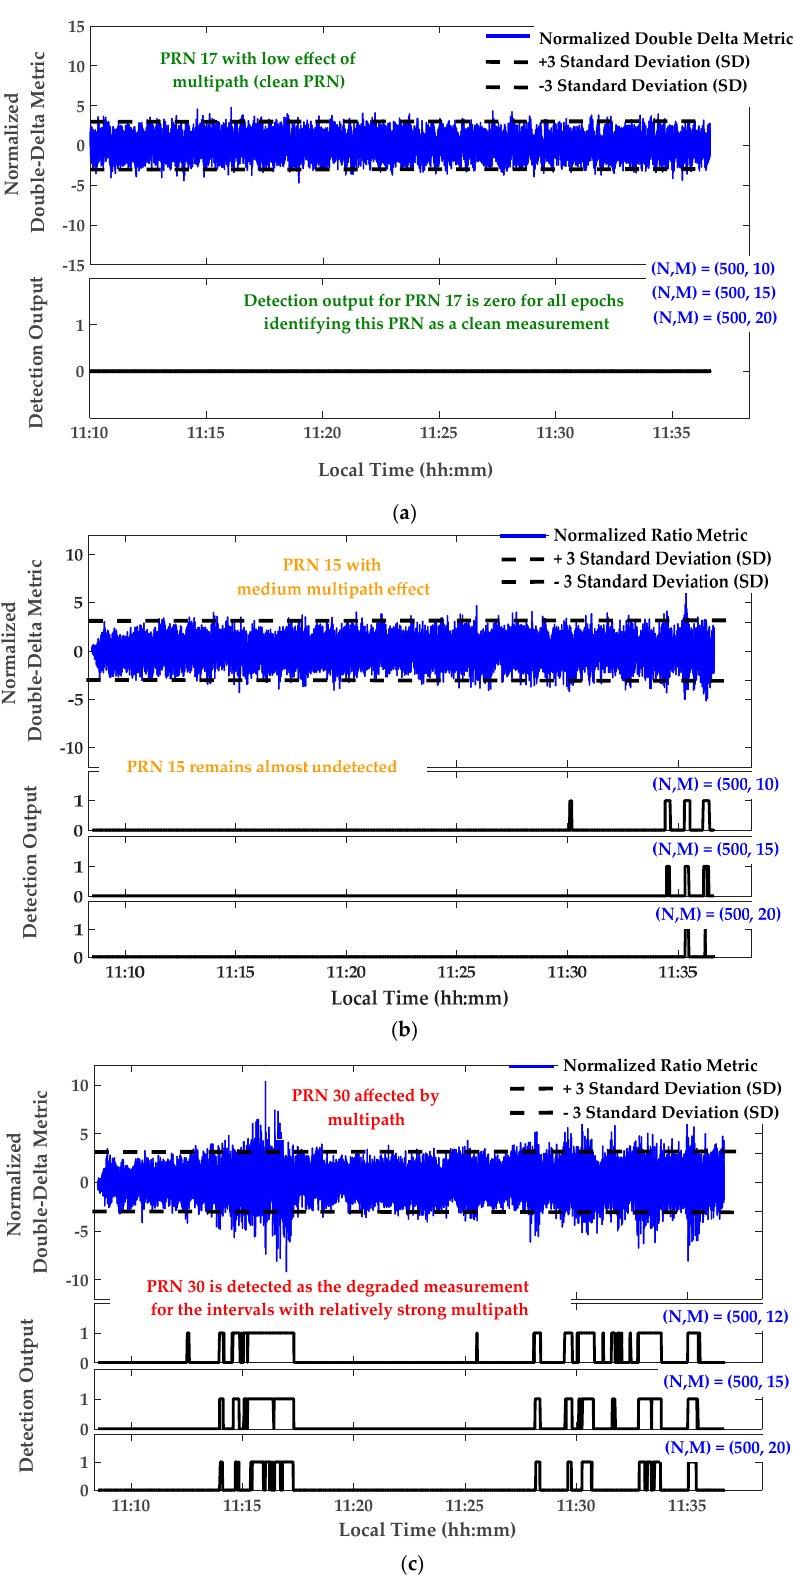
Figure 9. Signal quality monitoring—Normalized Double-Delta metric and corresponding detection outputs—Static scenario; ( a ) PRN 17; ( b ) PRN 15; ( c ) PRN 30.